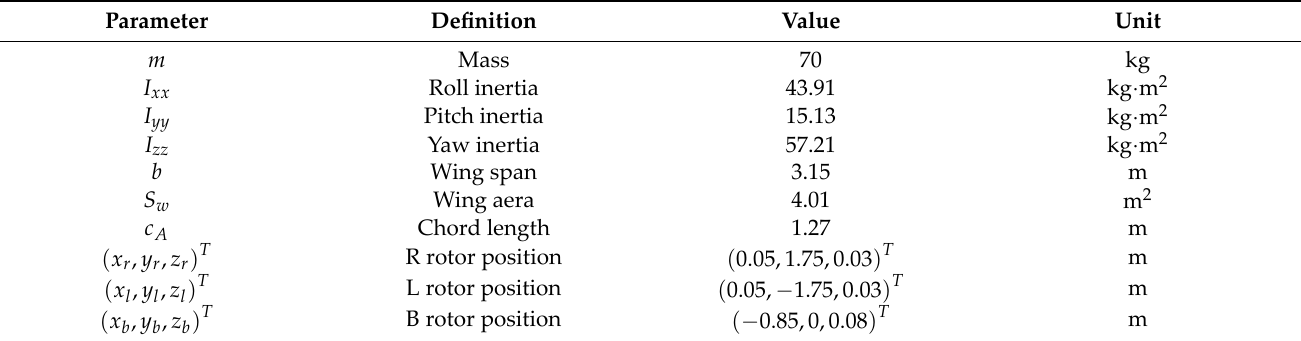
Table 1. The model parameters of the tilt‑rotor